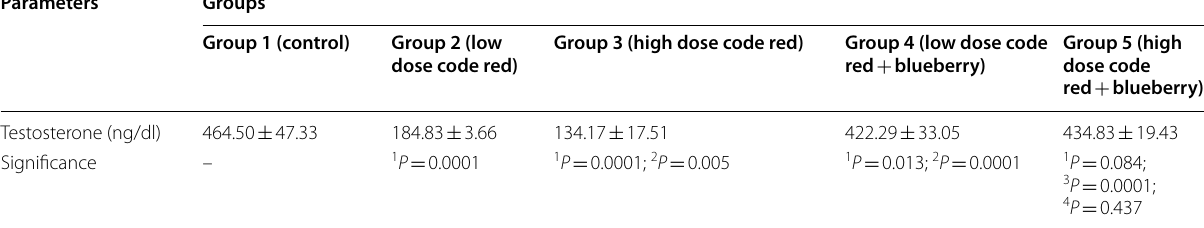
Data are presented as mean SD derived from six samples obtained from the six rats in each group. The statistical significance ( P value) between different groups is ± calculated, and the P < 0.05 are considered statistically significant 1 P : significance versus group 1 (Control); 2 P : significance versus group 2 (Low dose Code Red); 3 P : significance versus group 3 (High dose Code Red); 4 P : significance versus Group 4 (Low dose Code Red